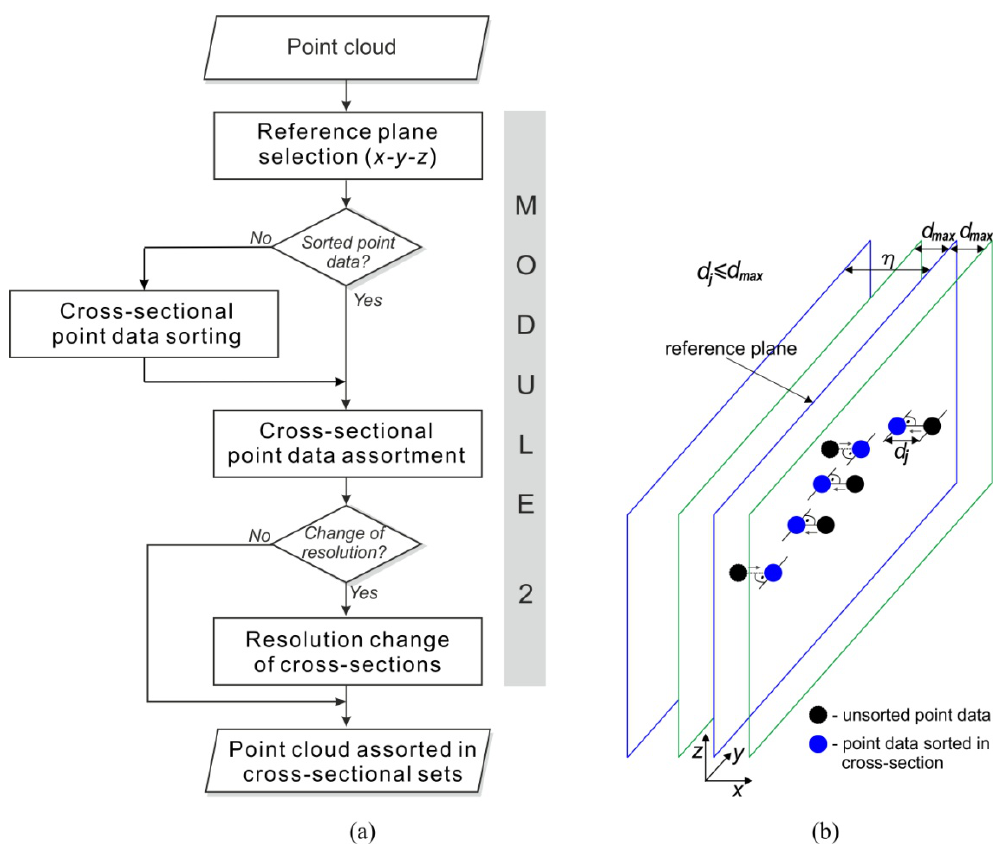
Figure 3. ( a ) Algorithm of module for extraction of cross-sectional curves. ( b ) Principle of the integrated approach for cross-sectional point data extraction from unsorted point